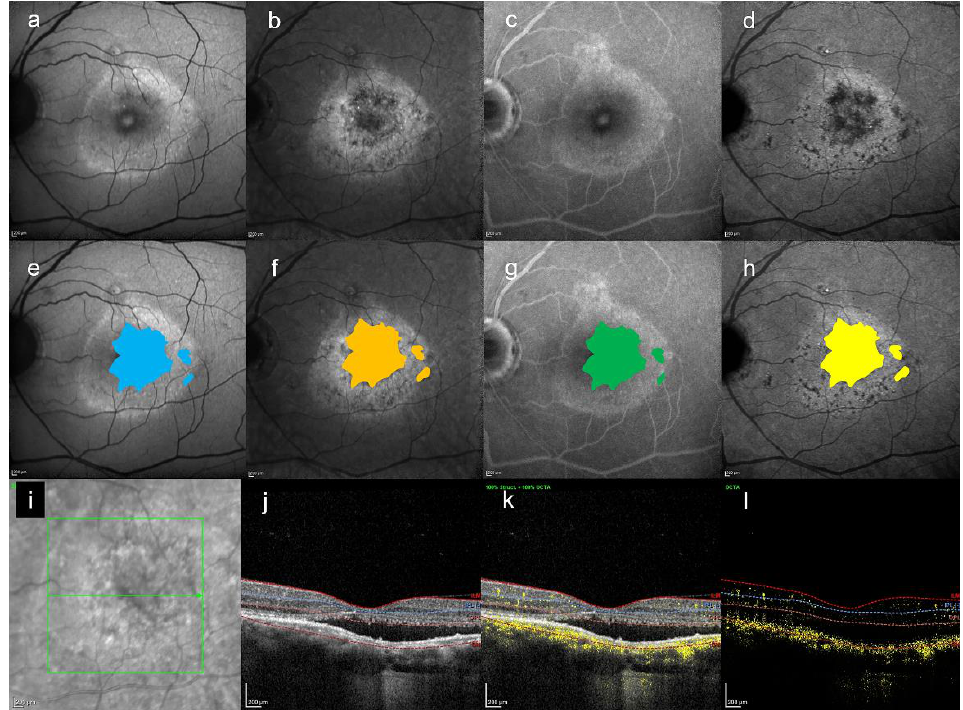
Figure 4. A 48-year-old man with bilateral CSC. All images are the fellow eye of the patient de- scribed in Figure 3. ( a ) SW-FAF image, ( b ) NIR-AF image, ( c ) FA image acquired at 19 min, and ( d ) ICGA image acquired at 26 min. All images were acquired on the same day. ( e ) Abnormal foci which were colored in blue on ( a ), which are within the HFF area on ( d ). The area is 4.6 mm 2 . ( f ) Abnormal foci which were colored in orange on ( b ), which are within the HFF area on ( d ). The area is 4.7 mm 2 . ( g ) Abnormal foci which were colored in green on ( c ), which are within the HFF on ( d ). The area is 4.6 mm 2 . ( h ) The HFF which were colored in yellow on ( d ). The area is 4.7 mm 2 . ( i , j ) Infrared + OCT (horizontal section) through the fovea. ( i , k ) Infrared + OCT angiography (hori- zontal section) through the fovea. ( i , l ) The image of ( k – j ). There is no choroidal neovascularization but a focal choroidal excavation.